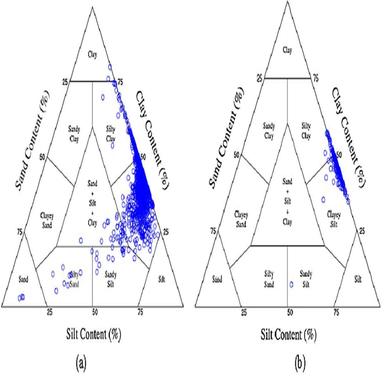
Ternary grain size plots for (a) KG & (b) MH basin from NGHP-01 expedition.